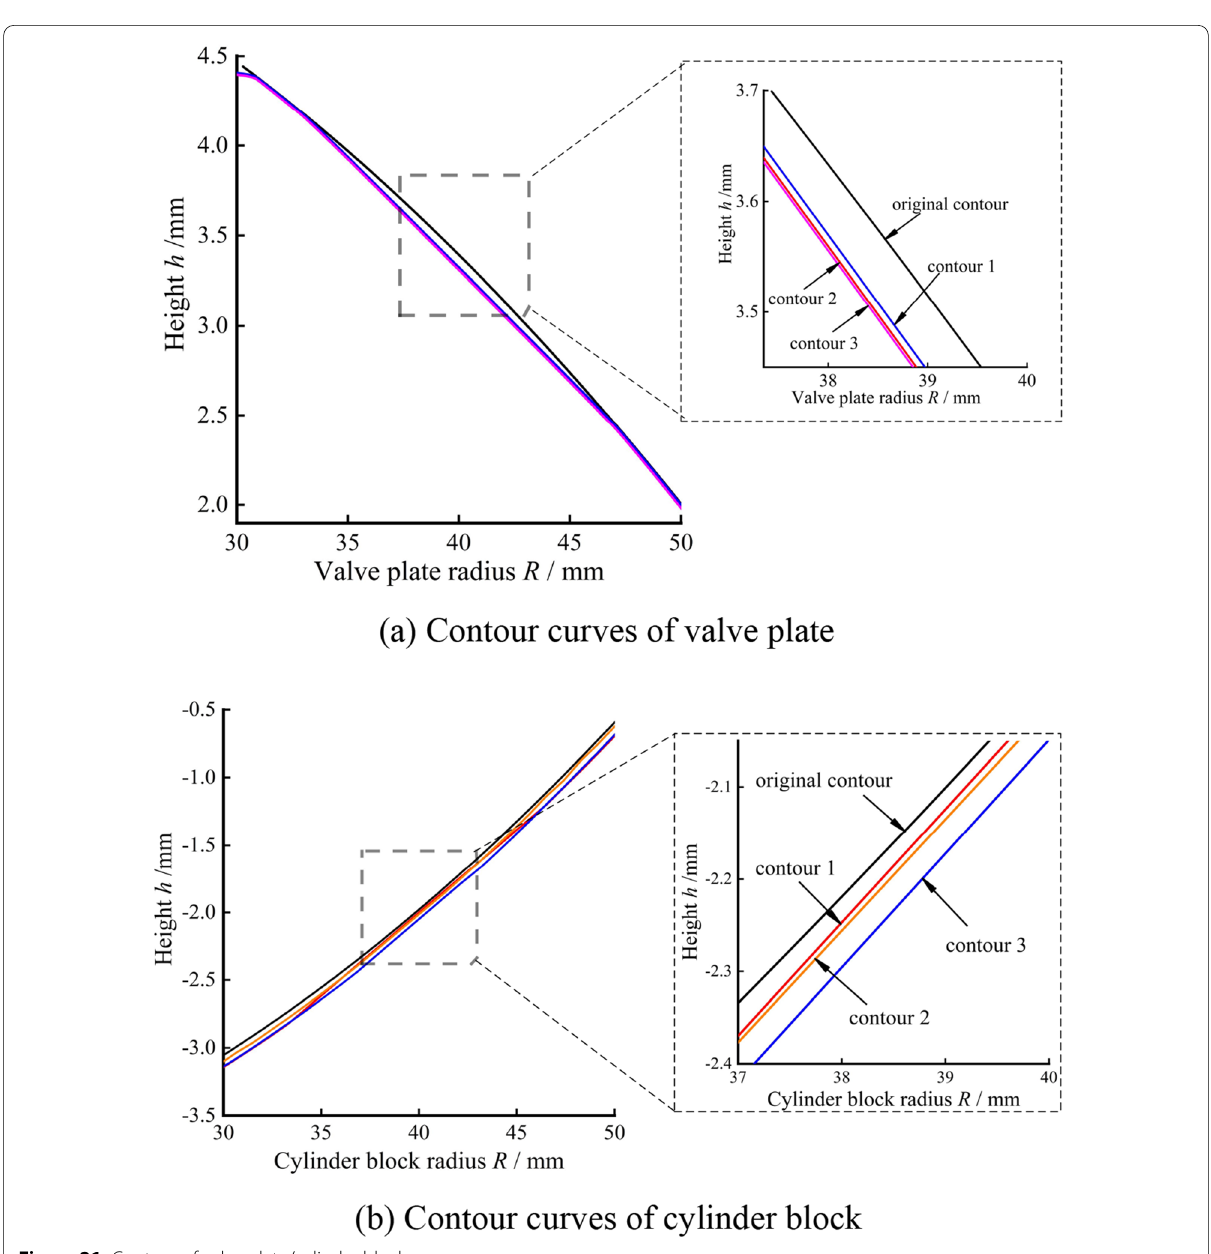
Figure 21 Contour of valve plate/cylinder